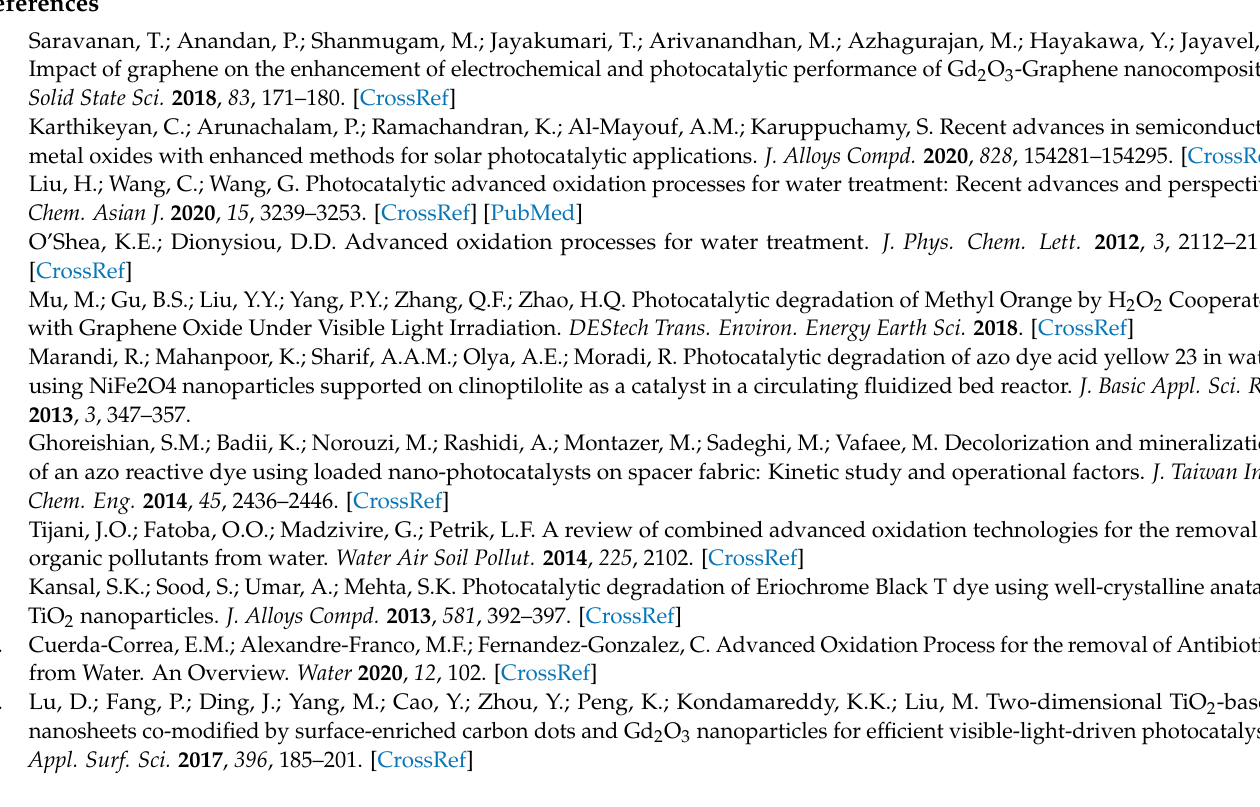
Figure S2: UV-vis absorption spectra of photocatalytic degradation of the AO7 dye (a) UV/H 2 O 2 (b) H 2 O 2 /Gd 2 O 3 (c) UV/H 2 O 2 /Gd 2 O 3 (d) UV/Gd 2 O 3 methods within the time period of 100 min. (Experimental conditions: initial dye concentration 0.042 mM; wavelength of UV irradiation: 254 nm; H 2 O 2 concentration: 500 mM; photocatalyst concentration: 1.0 g/L.), Figure S3: UV-vis absorp- tion spectra of photocatalytic degradation of the AY23 dye (a) UV/H 2 O 2 (b) H 2 O 2 /Gd 2 O 3 ( c ) UV/H 2 O 2 /Gd 2 O 3 (d) UV/Gd 2 O 3 methods within the time period of 100 min. (Experimental condi- tions: initial dye concentration 0.042 mM; wavelength of UV irradiation: 254 nm; H 2 O 2 concentration: 500 mM; photocatalyst concentration: 1.0 g/L.), Figure S4: UV-vis absorption spectra of the (a) MO, (b) AO7, (c) AY23 under 254 nm irradiation and (d) MO, (e) AO7, (f) AY23 under 365 nm irradiation within the time period of 100 min. (Experimental conditions: initial dye concentration 0.042 mM.) Figure S5: UV-vis absorption spectra of photocatalytic degradation of the (a) MO, (b) AO7, (c) AY23 by UV/H 2 O 2 methods under 254 nm irradiation and (d) MO, (e) AO7, (f) AY23 under 365 nm irradiation within the time period of 100 min. (Experimental conditions: initial dye concentration 0.042 mM; H 2 O 2 concentration: 4.8